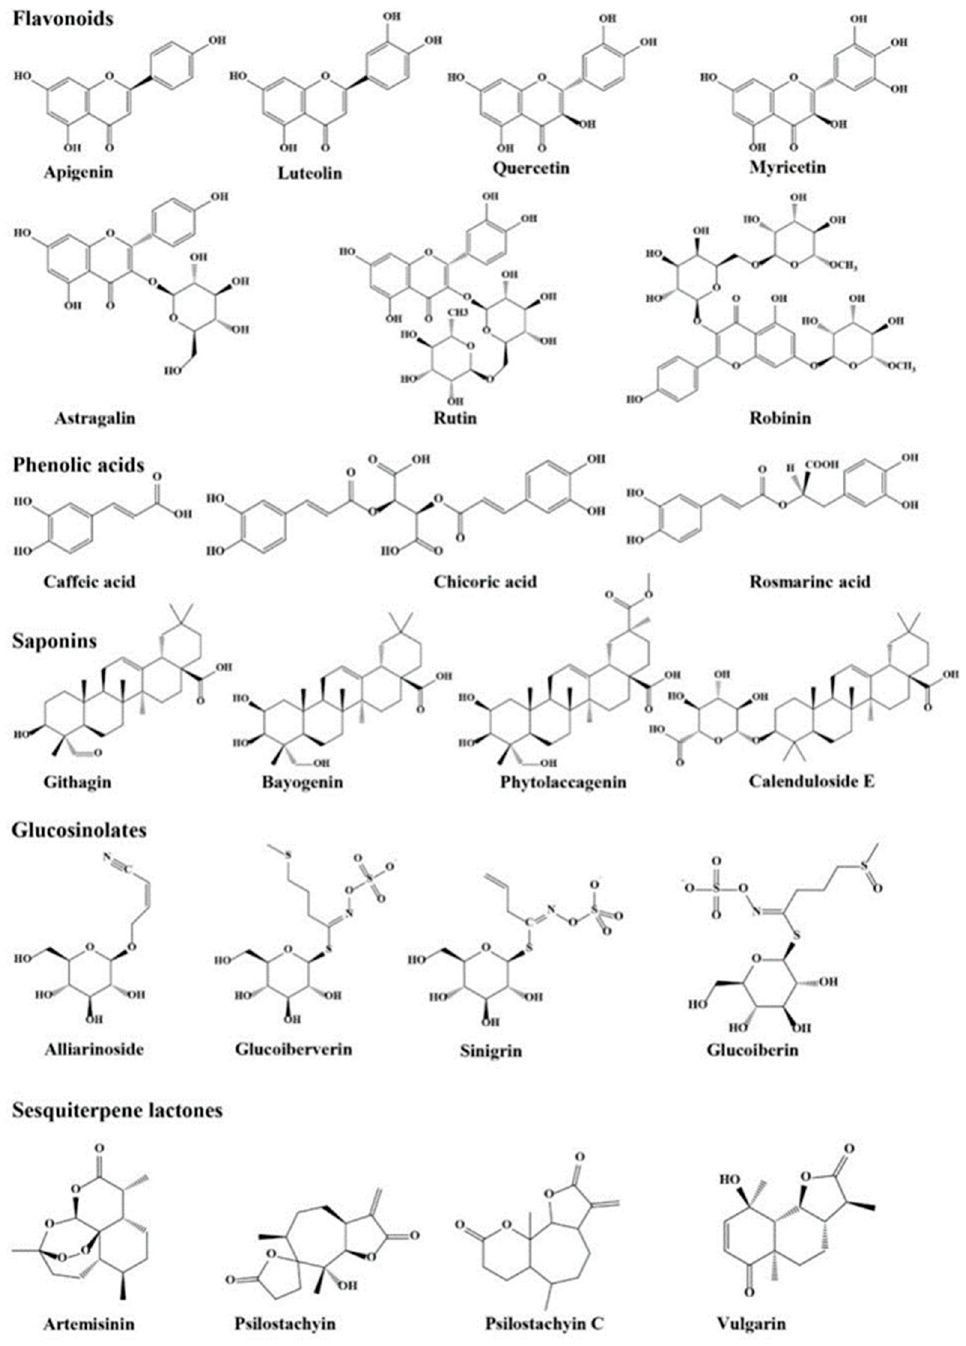
Figure 5. Chemical structures of some plant-derived compounds responsible for the biological activities reported for the taxa covered in the study.